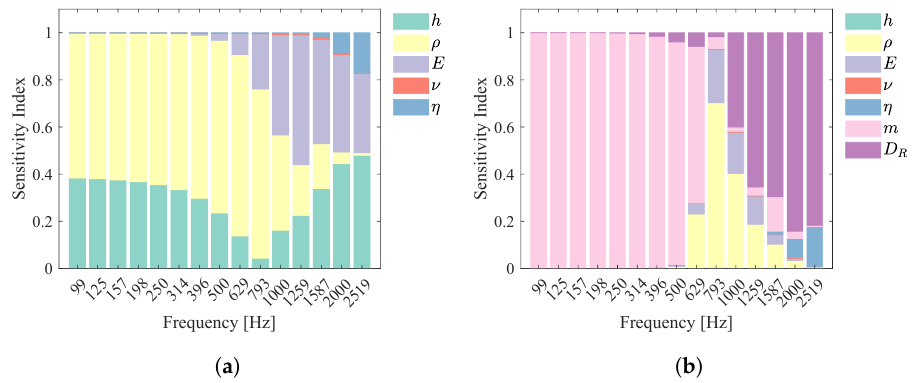
Figure 5. The mean decrease in impurity (MDI)-based sensitivity indices of the STL with the analytical infinite plate model: ( a ) the inputs of the surrogate only consist of the STL variables ( RMSE = 0.21 ± 0.00 dB); ( b ) physics-guided features m and D R are included as input for the surro- gate ( RMSE = 0.12 ± 0.01